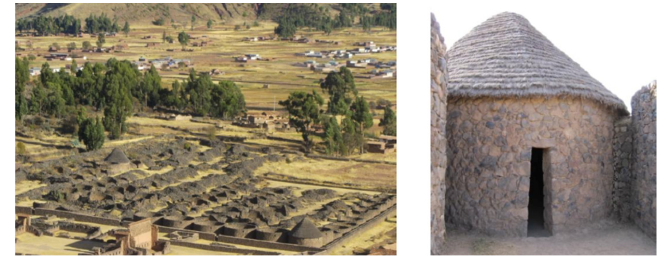
Figure 1. Examples of historical field stone silos (Perú, South America).